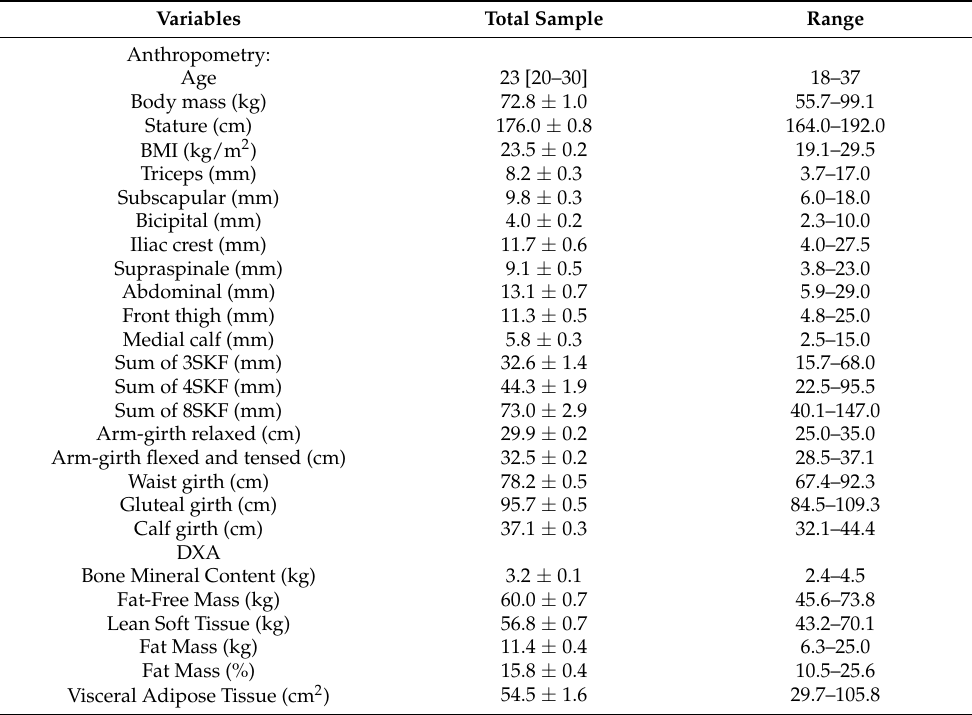
Table 1. The participants’ anthropometric and body composition characteristics ( n = 78).